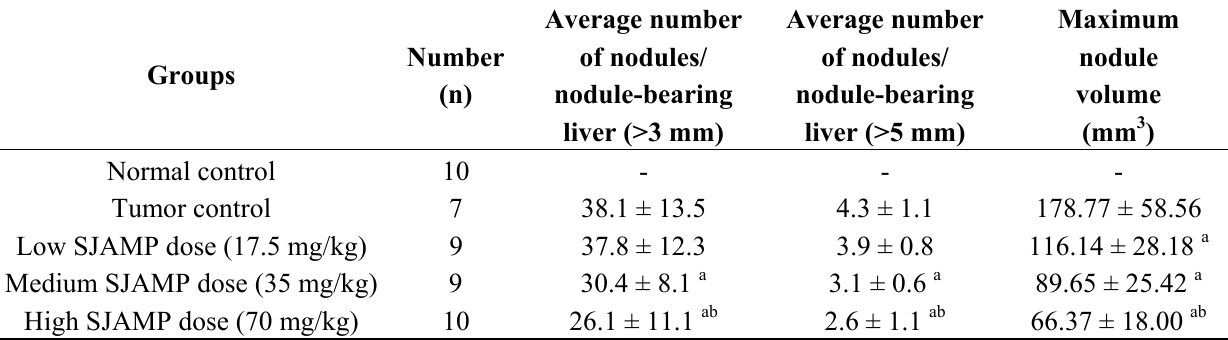
Average number of nodules/ nodule-bearing liver (>5 mm)